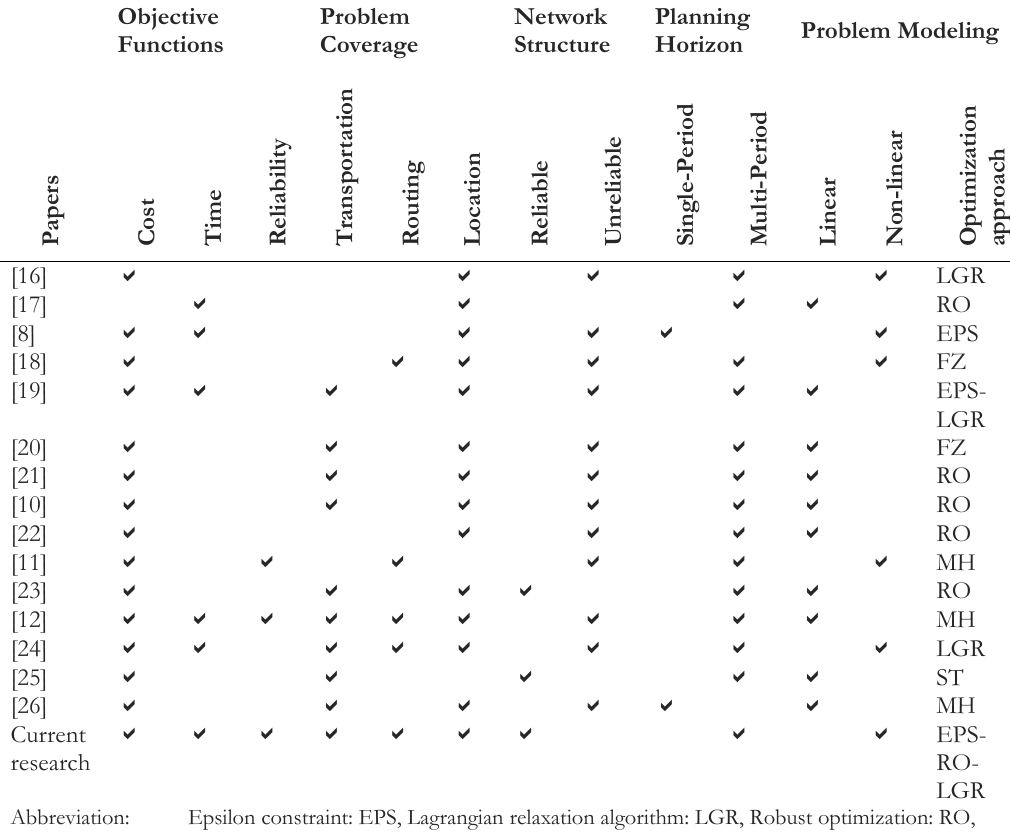
Table 1. Review of some existing